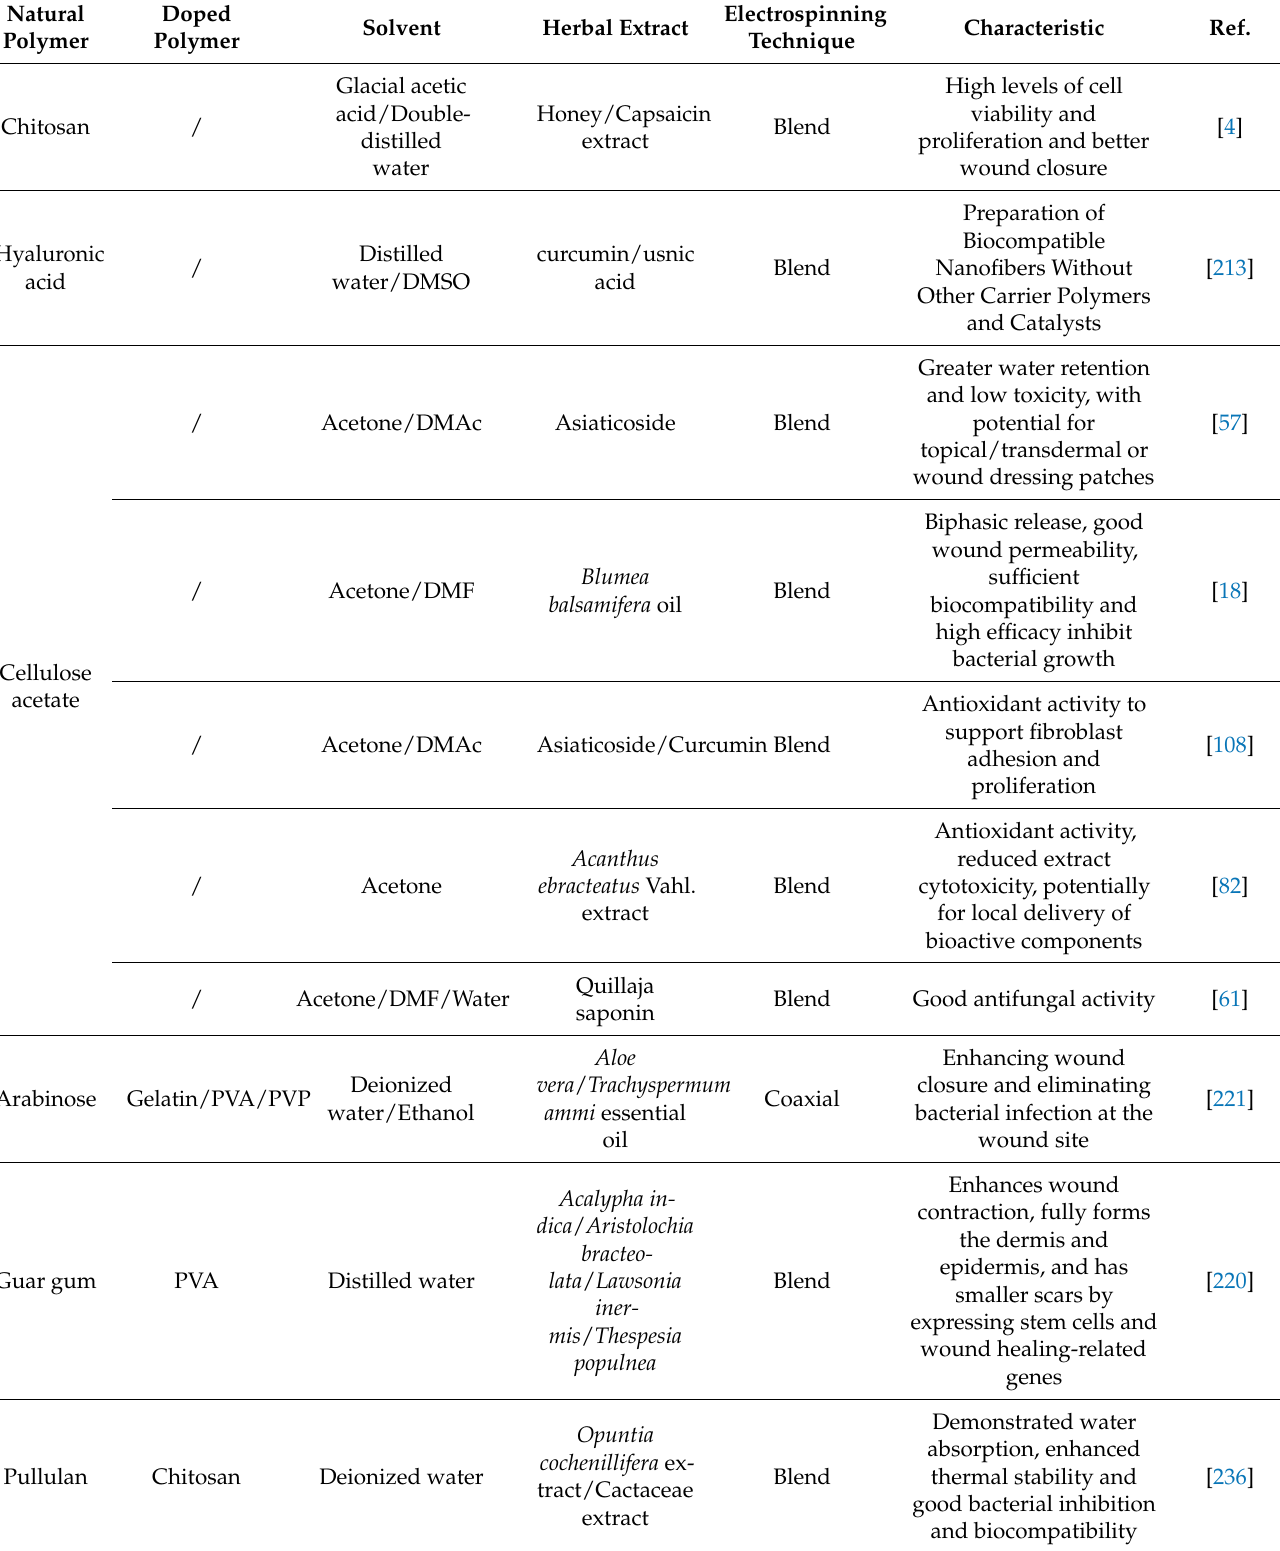
Table 4. Characteristics of electrospun herbal medicine natural polymer